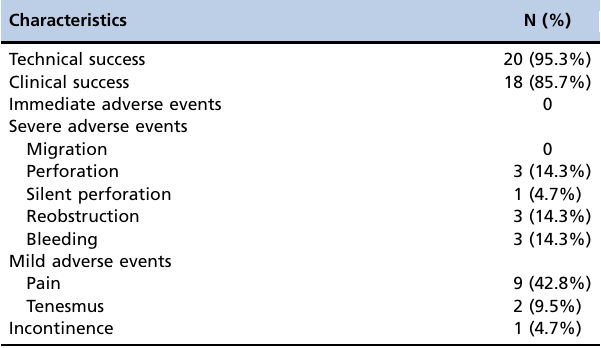
Table 2 - Technical success, clinical success, and adverse event rates of endoscopic